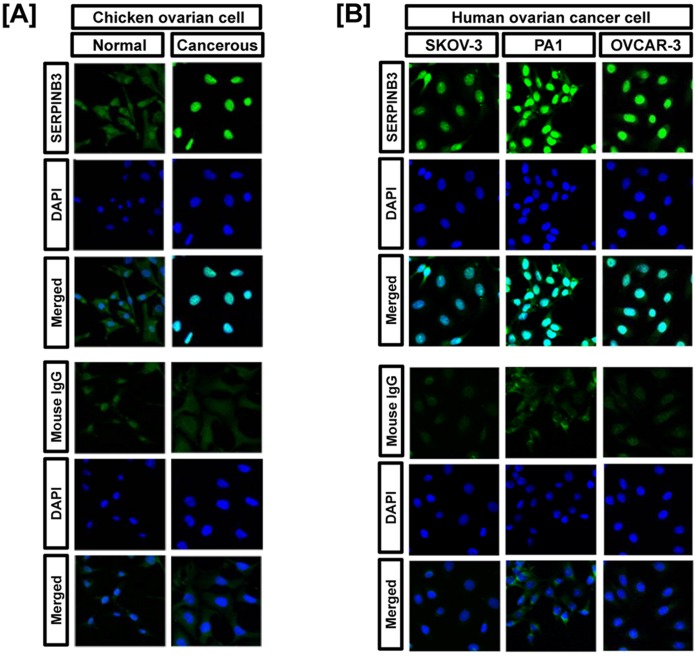

In vitro target assay of microRNAs on the SERPINB3 transcript.[A] Diagram of miR-101, miR-1668 and miR-1681 binding sites in SERPINB3 3′-UTR. [B] Expression vector maps for eGFP with SERPINB3 3′-UTR and mutated SERPINB3 3′-UTR and Ds-Red with each miRNA. The wild-type (WT) and mutants of 3′-UTR of the SERPINB3 transcript were subcloned between the eGFP gene and the polyA tail to generate the fusion construct of the GFP transcript following the miRNA target 3′-UTR (pcDNA-eGFP-3′UTR) (top and middle panel) and the miRNA expression vector was designed to co-express DsRed and each miRNA (pcDNA-DsRed-miRNA) (bottom panel). [C] After co-transfection of pcDNA-eGFP-3′UTR for the SERPINB3 transcript and pcDNA-DsRed-miRNA for the miR-101, miR-1668 and miR-1681, the fluorescence signals of GFP and DsRed were detected using fluorescent microscopy. [D] The rate of inhibition of eGFP expression from miRNA modulation was calculated by fluorescence-activated cell sorting (FACS). Solid bars represent WT of SERPINB3 3′-UTR and empty bars show the mutant of SERPINB3 3′-UTR for each miRNA. Error bars indicate the standard error of triplicate analyses. The asterisks denote statistically significant differences between WT vs. mutants (***P<0.001).